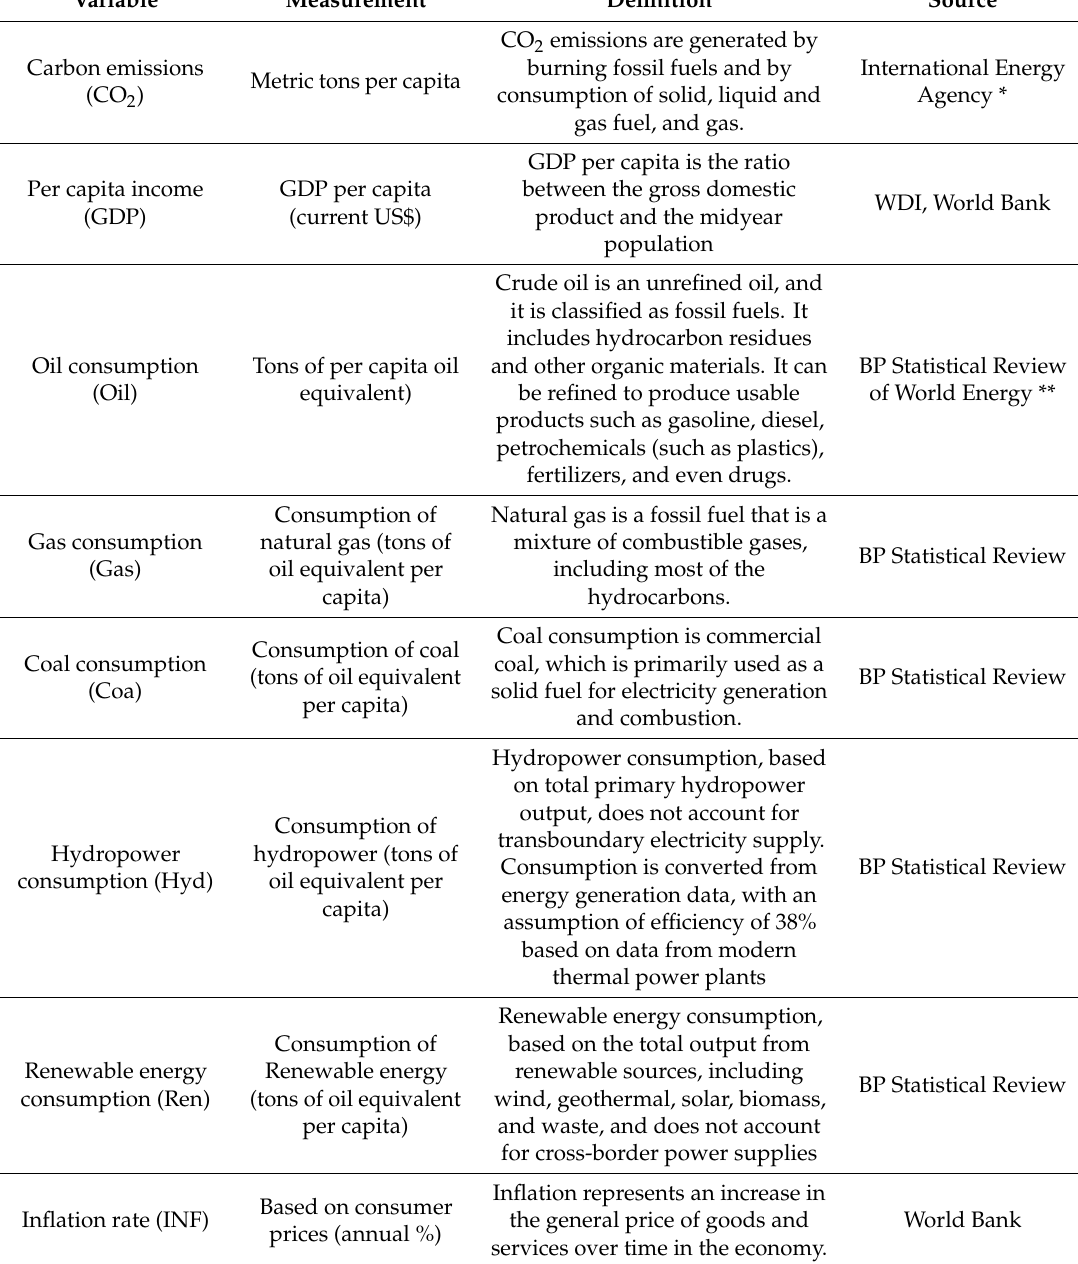
Table 1. Definitions of the